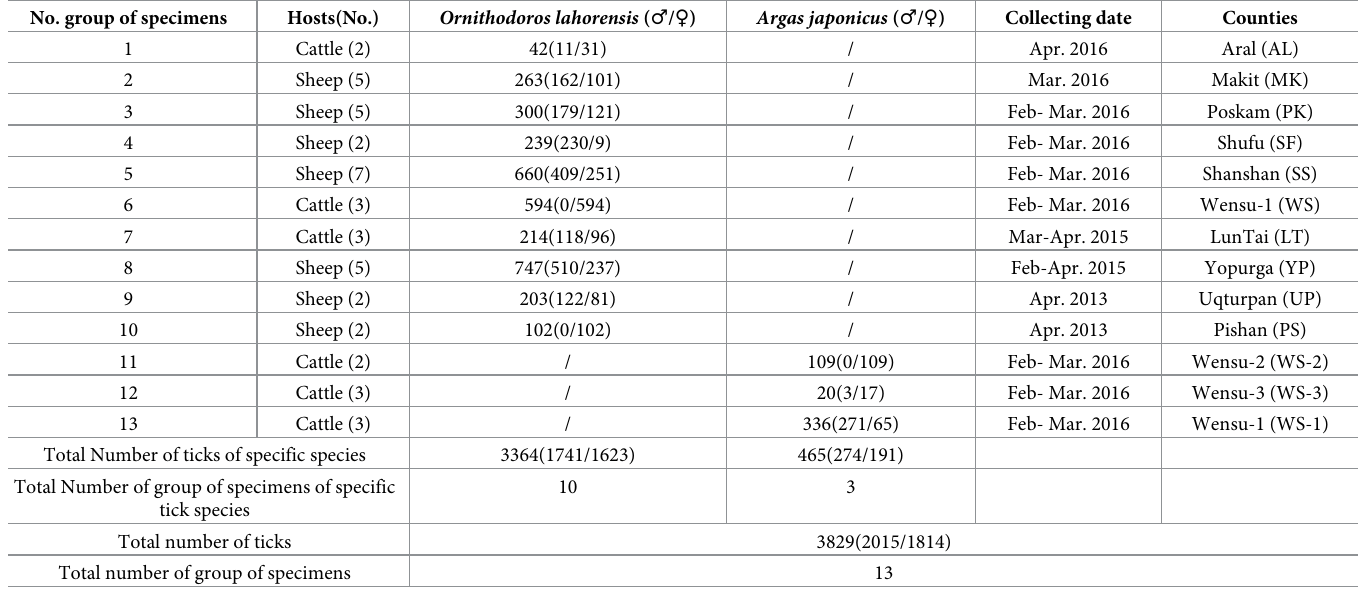
Table 1. The counts of each argasid species collected at the sampling sites around Tarim Basin between 2013 and 2016. No. group of